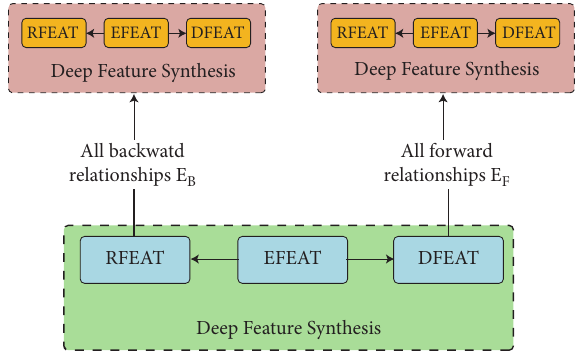
Figure 2: Deep feature synthesis